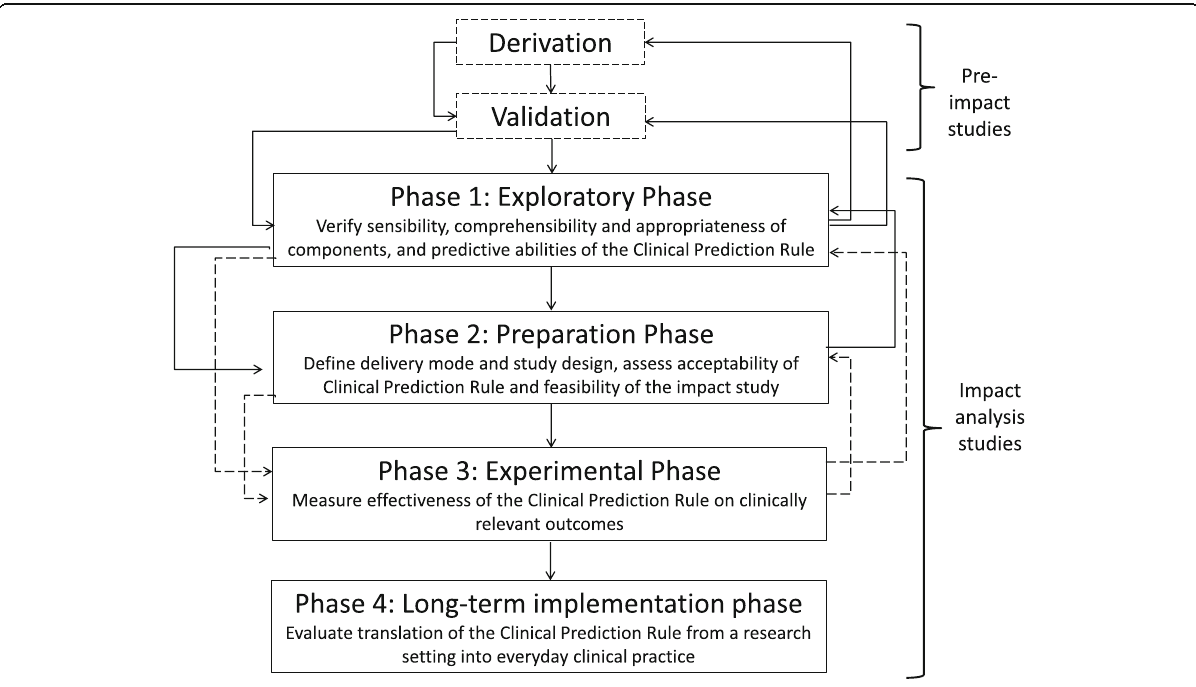
Fig. 2 The four phases of impact analysis for a clinical prediction rule. Reproduced with permission from Wallace et al. 2011